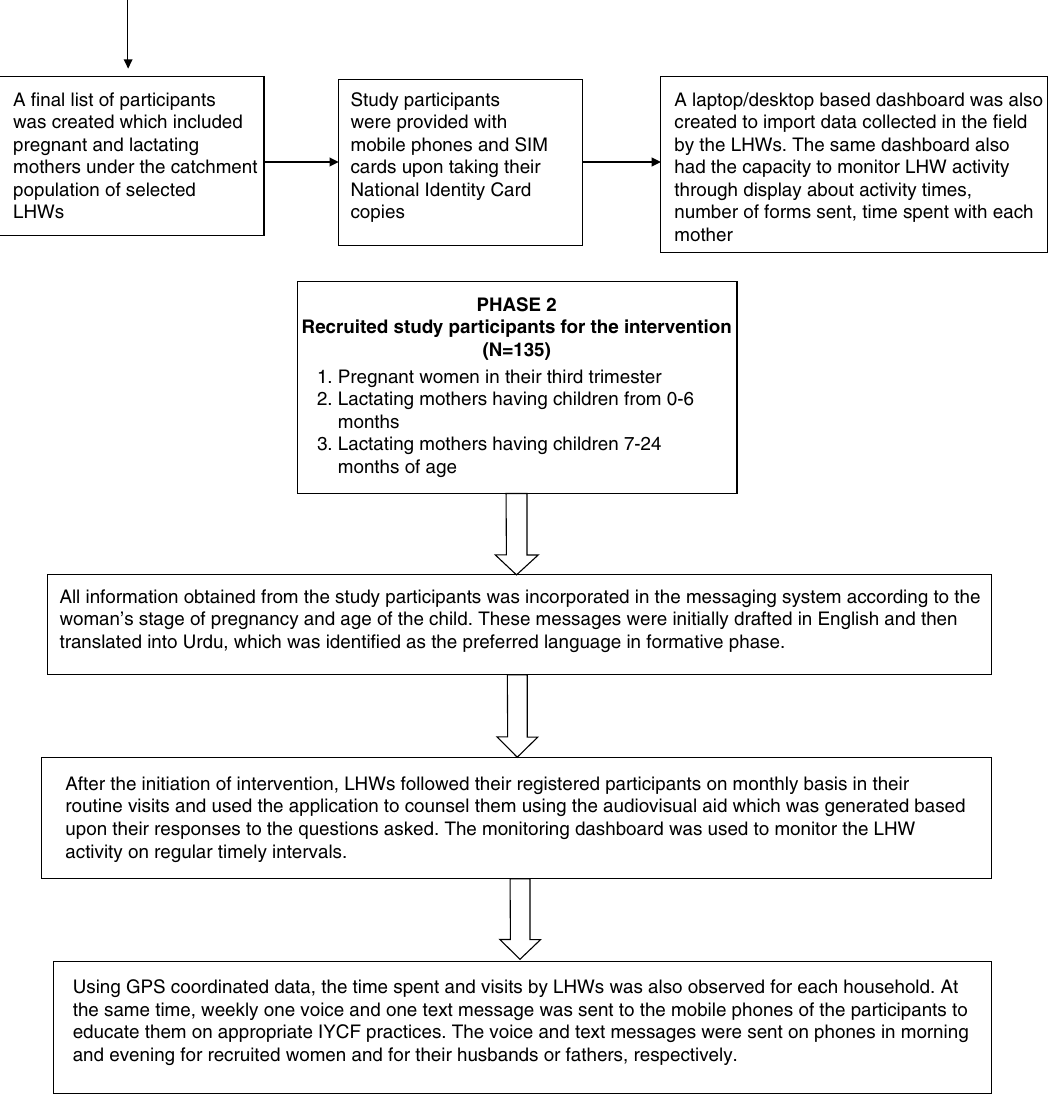
Figure 1. Intervention Phase among pregnant & lactating mothers in rural Islamabad from July to December